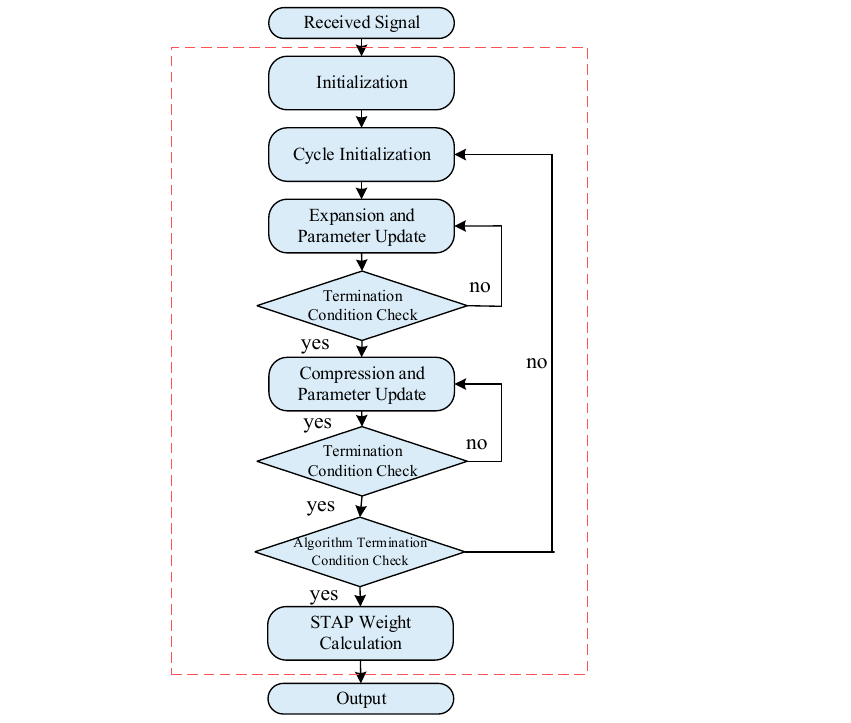
Figure 2. Processing flowchart of the proposed algorithm.